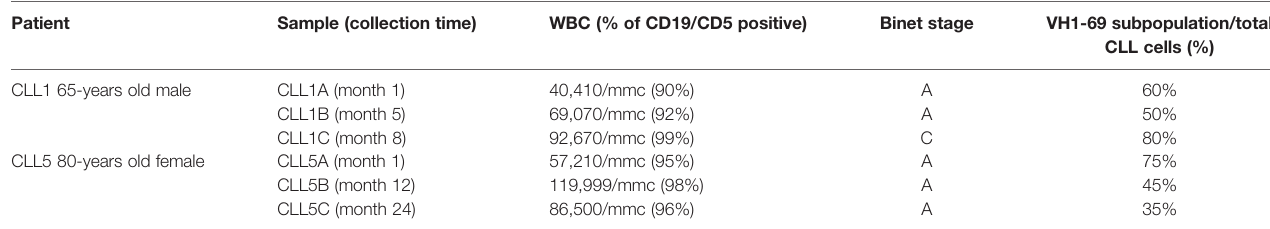
TABLE 1 | Clinical and molecular data of CLL1 and CLL5 patients.